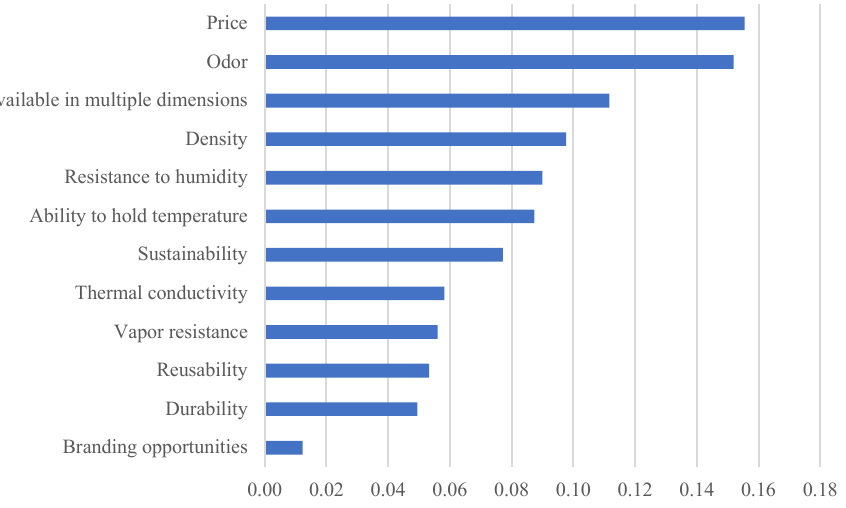
Fig. 1. Weighed criteria in ascending order regarding their